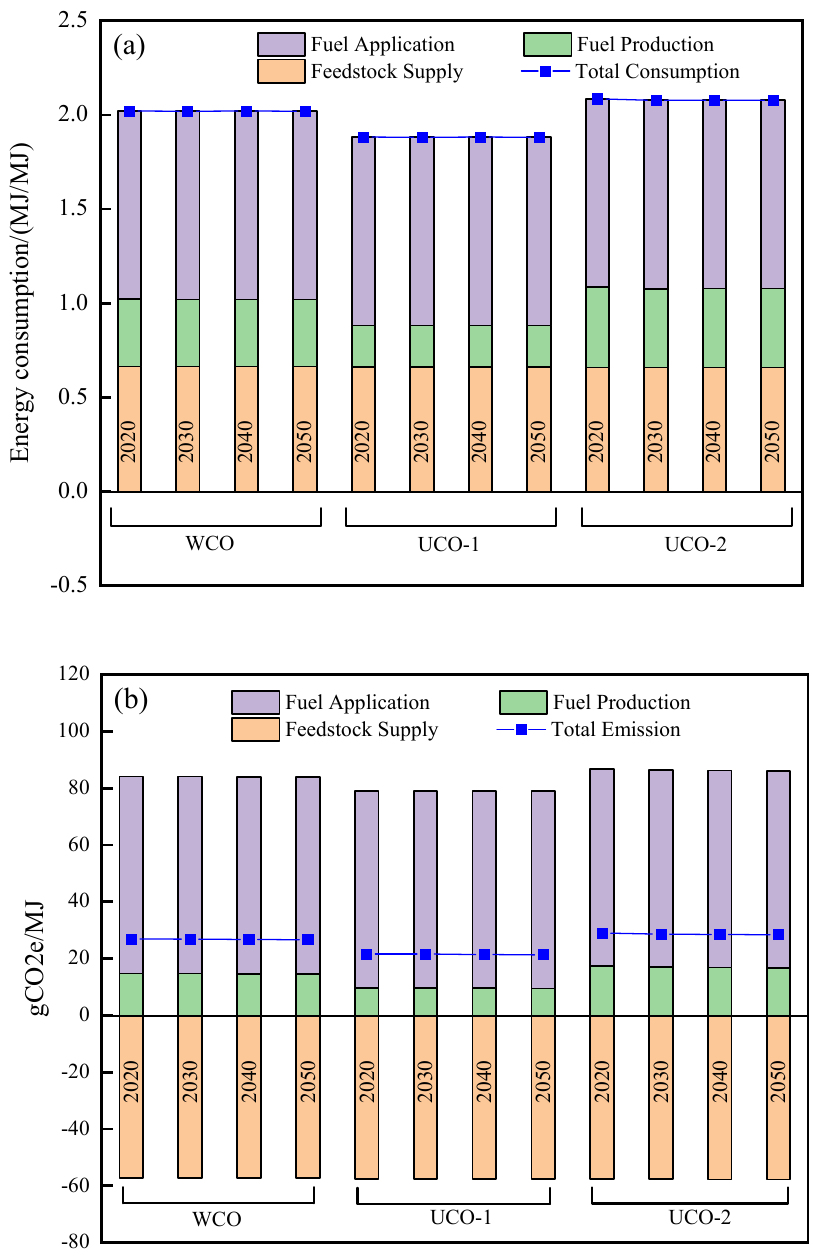
Figure 6. ( a ) Life-cycle energy consumption in different years. ( b ) GHG emissions in different years. Electricity was used in different stages. The proportions of electricity in the total en- ergy consumption of WCO, UCO-1, and UCO-2 were 5.7, 1.8, and 1.0%, respectively, and the GHG emission proportions were 5.7, 1.6, and 1.0%, respectively. For WCO in 2030, 2040, and 2050, the total energy consumption was reduced by 6.6, 1.7, and 4.4% from 2030 to 2050, and GHG emissions were reduced by 4.6, 31.9, and 45.1%, respectively. The general trend in the power structure was that the proportion of fossil energy power generation, represented by coal, gradually decreased and the renewable energy power generation gradually increased. Although the energy consumption and GHG emis- sions increased temporarily from 2030 to 2040, owing to the high energy consumption, the energy consumption and GHG emissions over the entire life cycle showed a decreasing trend because of technical progress. The power composition had a significant impact on the GHG emissions of bio-jet fuel, which also featured greater advantages in replacing traditional fossil fuels for the optimization of China’s power structure.